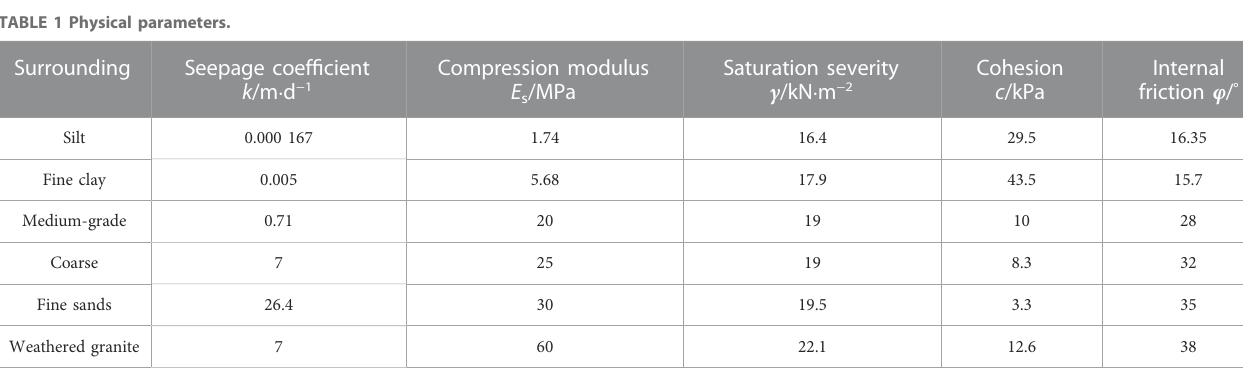
TABLE 1 Physical